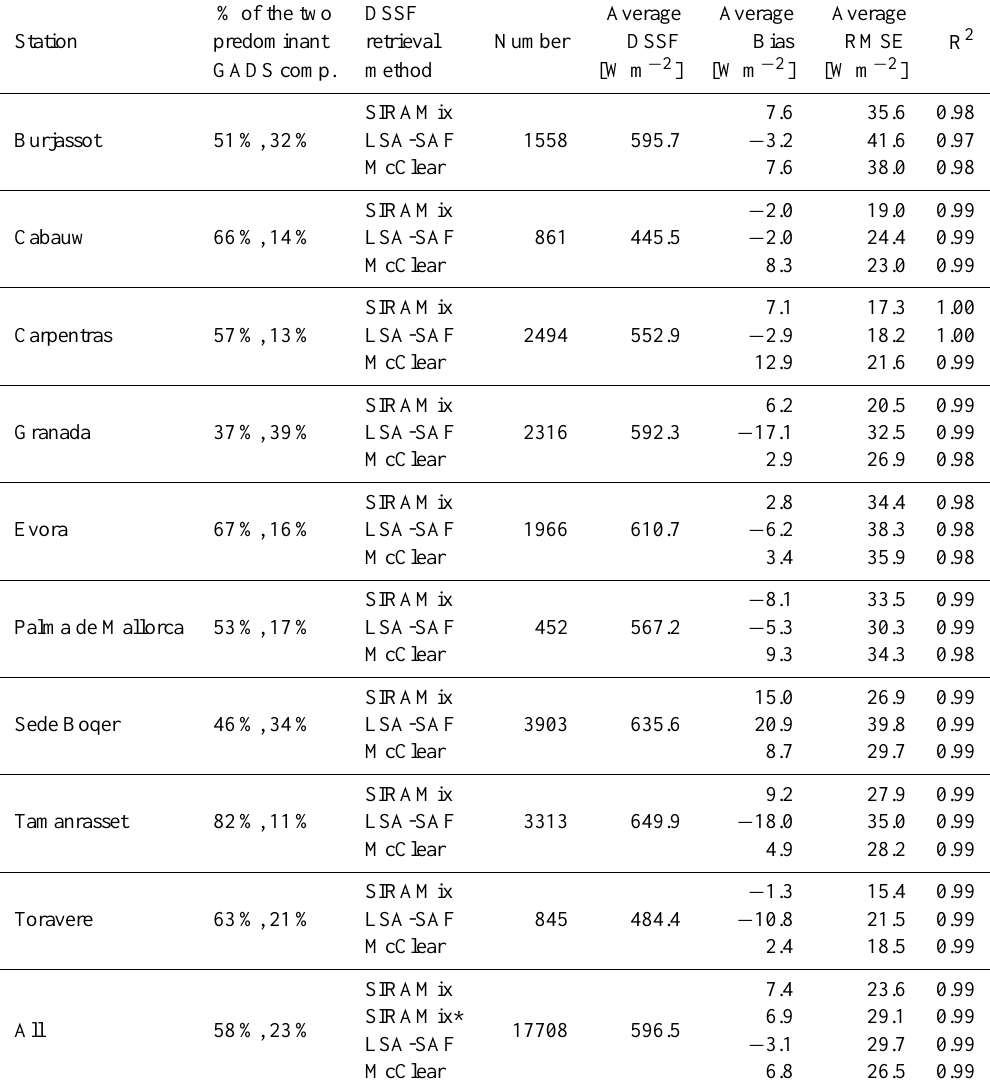
Table 6. Idem to Table 4 for global irradiance. Second columns details the percentage in total AOD of the two most abundant aerosol components for each station. In this way, stations with homogeneous aerosol conditions (e.g., Tamanrasset) can be distinguished from heterogeneous ones (e.g.,